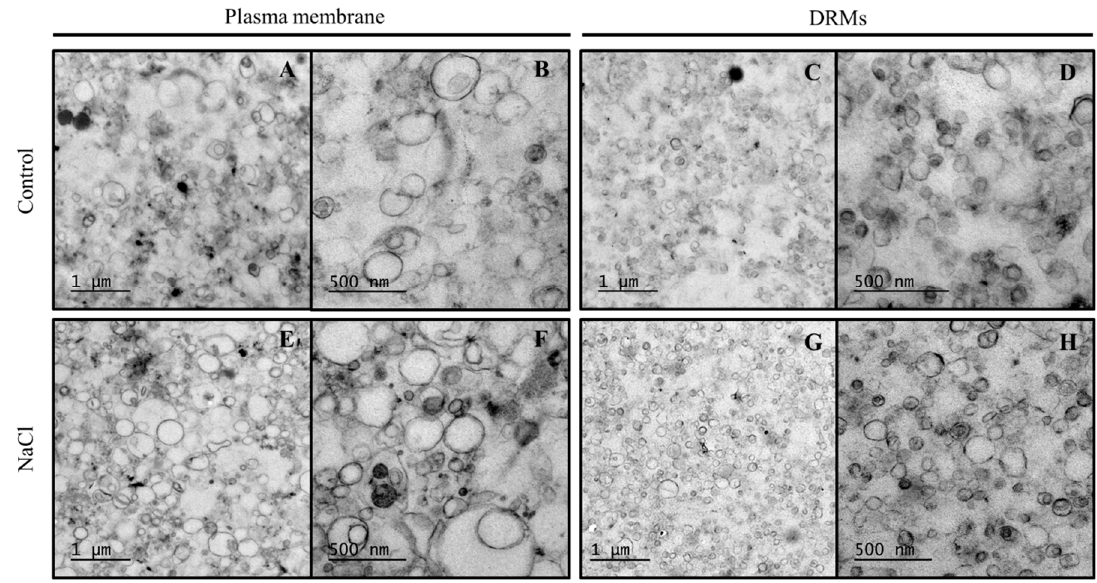
Figure 3. Transmission electronic microscopy images of control plasma membrane (PM) (1 µm) ( A ) and 500 nm ( B ), control detergent-resistant membranes (DRMs) (1 µm) ( C ) and 500 nm ( D ), NaCl PM and 500 nm ( B ), control detergent-resistant membranes (DRMs) (1 µ m) ( C ) and 500 nm ( D ), NaCl PM (1 µm) ( E ) and 500 nm ( F ), and NaCl DRMs (1 µm) ( G ) and 500 nm ( H ). (1 µ m) ( E ) and 500 nm ( F ), and NaCl DRMs (1 µ m) ( G ) and 500 nm ( H